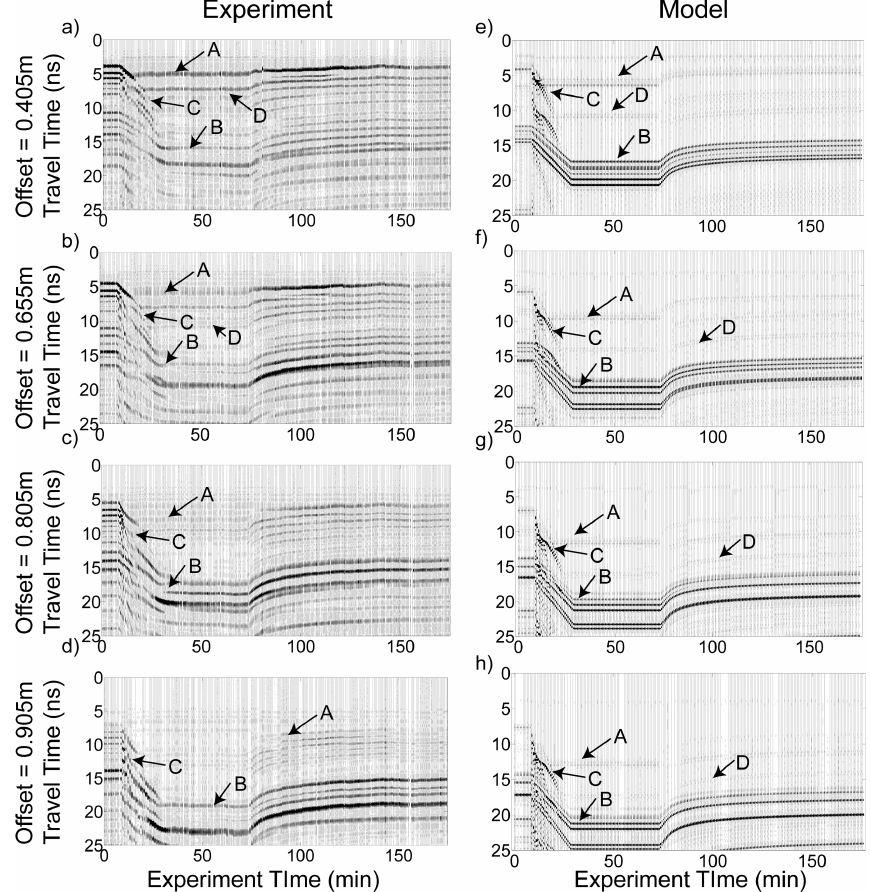
Fig. 6. Common offset projections for 4 of the 21 offsets of the experiment and model. Pointed out in the data are the groundwave (A), bottom of sand (sand–gravel interface) reflection (B), wetting front reflection (C), and side of tank reflection